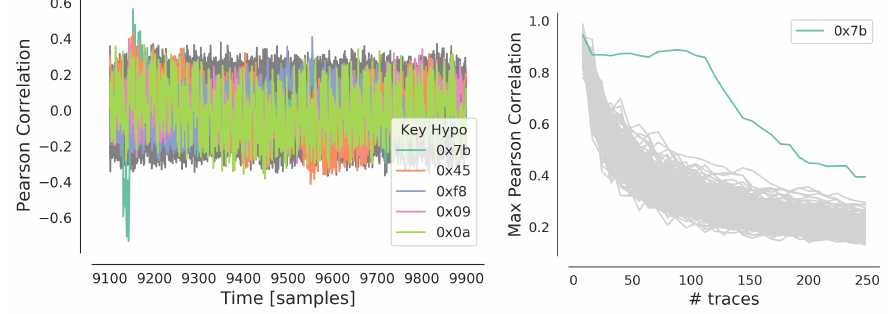
Figure 23: Pearson Correlation coefficients in Step 4 (byte 0), with 128 traces as a function of the time samples (left) and their maximum as a function of the number of traces